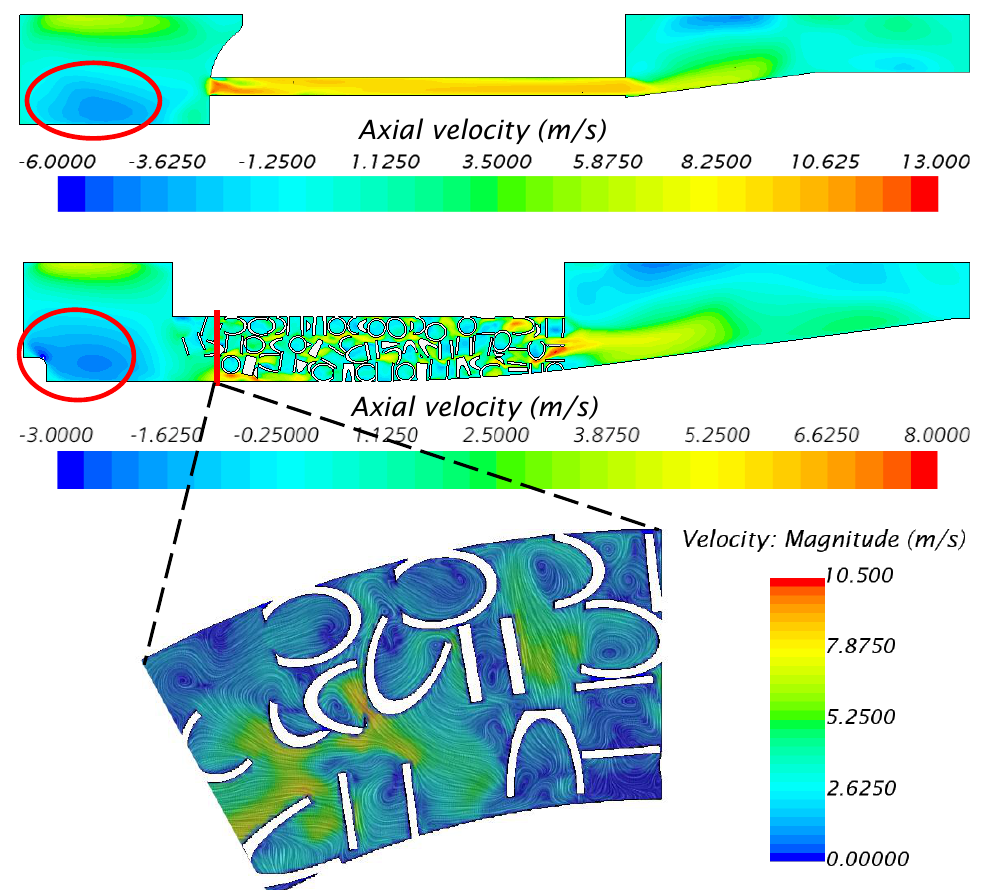
Figure 15. Axial velocity field computed on a longitudinal section for the mock-up with MCs ( a ) and RRs ( b ). Inset: details of the line integral convolution of the component of the velocity tangential to the represented section, colored by the velocity magnitude.